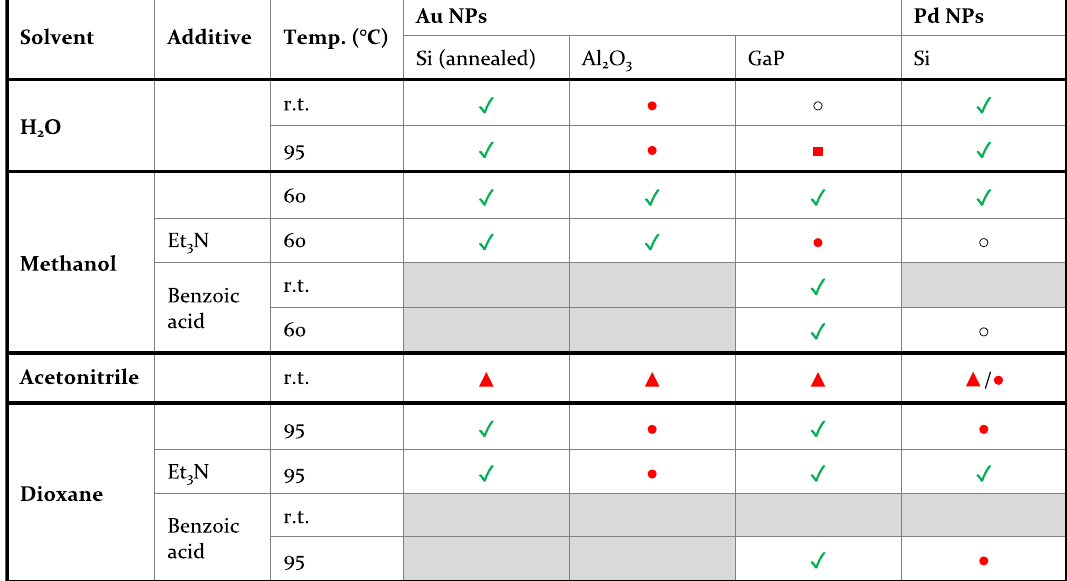
Table 2. Screening of the stability of supported nanoparticles in a selection of solvents when changing the material of the nanoparticles or the support. In selected cases with the addition of base/acid a,b . a General experimental: Nanoparticle supports immersed into 1 mL solvent or 1 mL solvent and 0.05 mM Et 3 N or 1 mL solvent and 0.05 mM BzOH for 24 h at room temperature or slightly below the boiling temperature of the solvent (maximum 95 °C). b —good stability; ○ —minor movement of nanoparticles; —major movement of